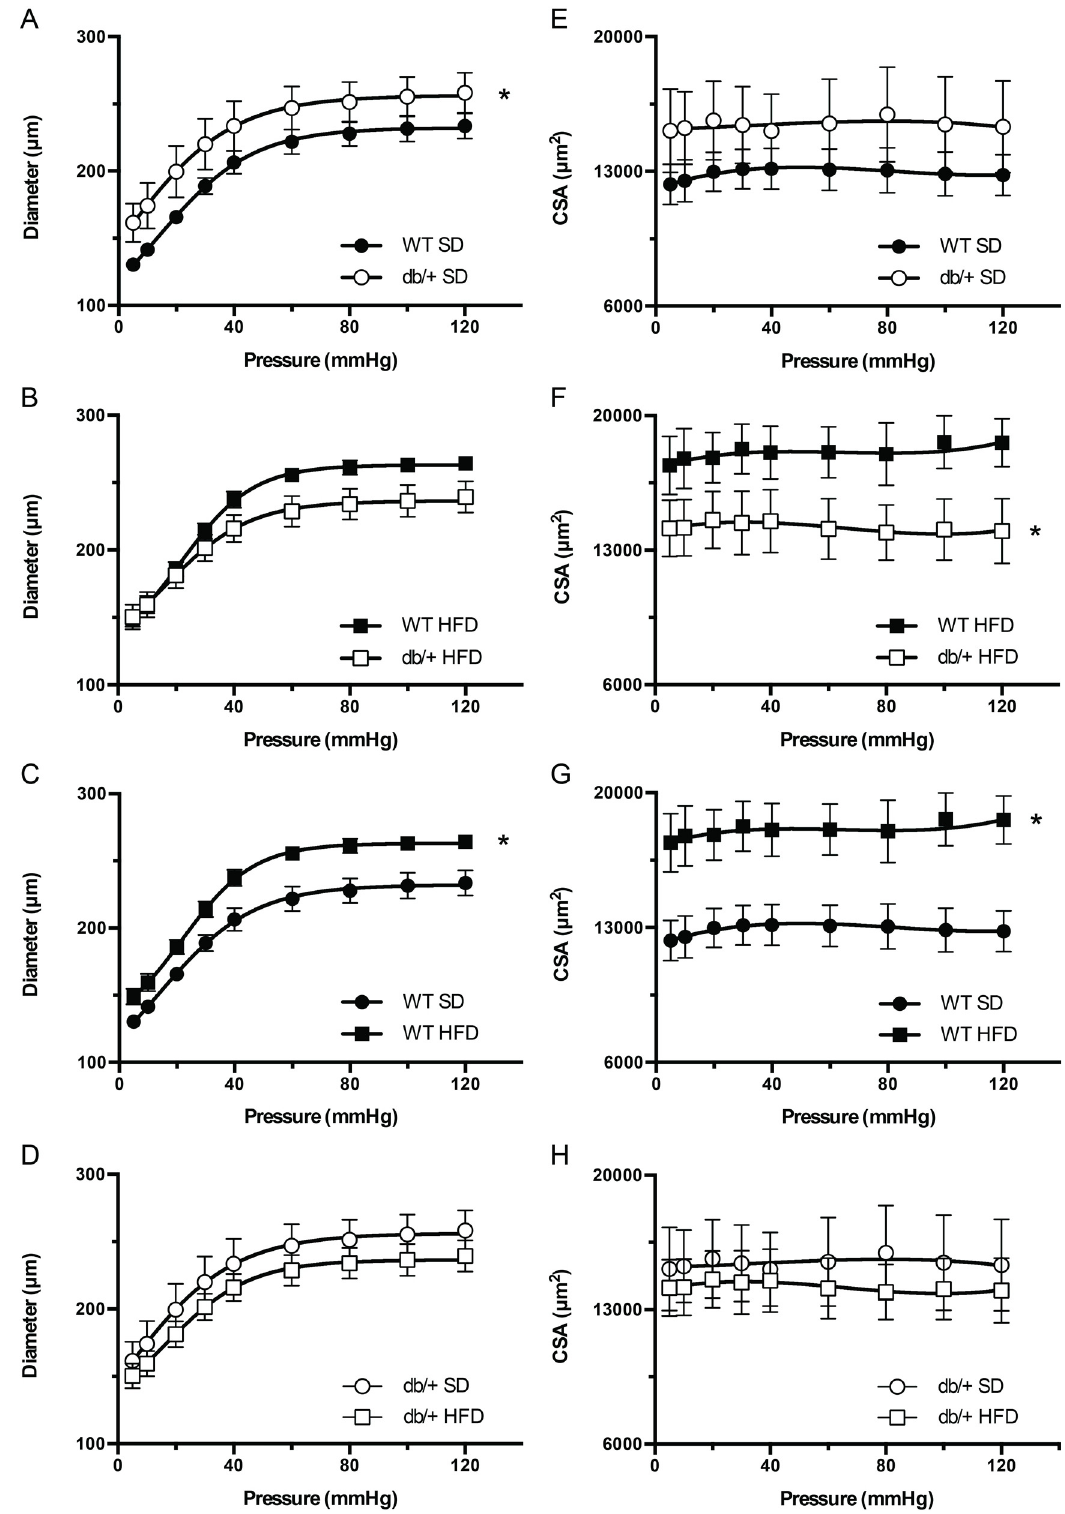
Fig 7. Effect of maternal environment and offspring diet on the structural properties of mesenteric resistance arteries from adult (31 week-old) wild type (WT) male offspring of WT-control or Lepr db/+ (db/+) dams. (A-D)